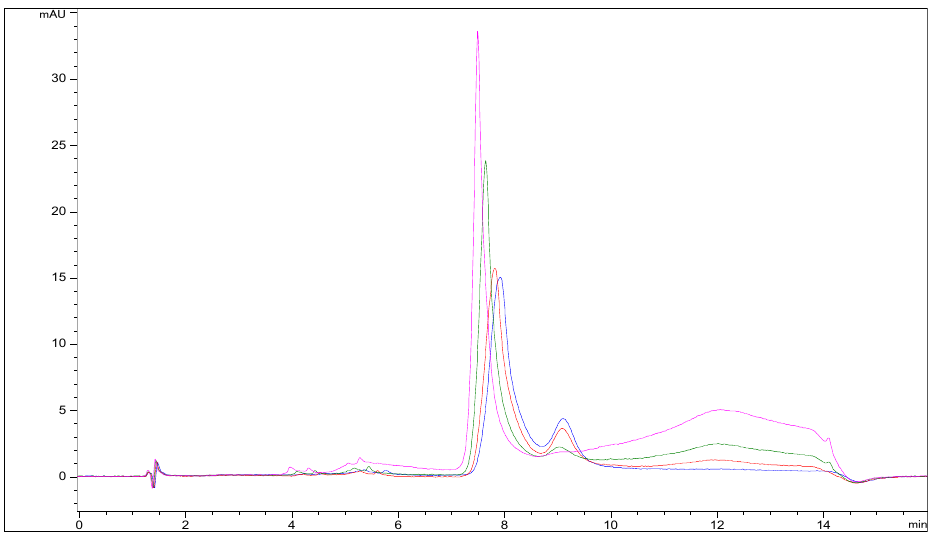
Figure A4. Comparison of optimized RP-HPLC methods on selected columns: ( a ) BioZen™ Intact XB-C8 column, ( b ) Zorbax 300SB-C3 column, ( c ) BIOShell™ A400 Protein C18 column, and ( d ) Vy- dac ® Protein C4 #197 column; −− control sample and −− alkaline stress sample.